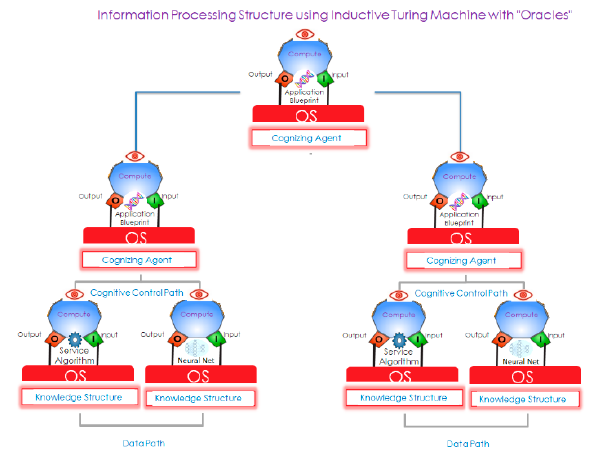
Figure 3. Turing machine managed by cognizing